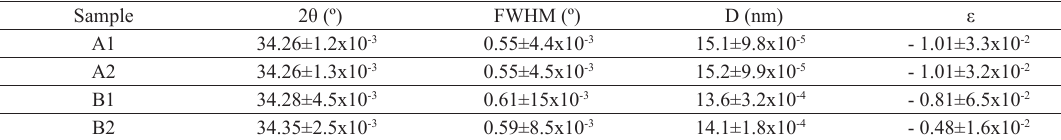
Figure 4. Scanning electron micrograph of the AZO/PET films deposited by RF (sample A2). Three positions are indicated where EDS measurements were made. The 001 and 002 positions, which are above cracks, exhibit high concentrations of C, owing to the PET substrate. In contrast, at position 003 only Zn, O and Al, which originate form AZO, are detected. Table 2. Position angles (2θ) and FWHM (β) of the (002) peaks of the spectra of the AZO films and estimated values of the crystallite size (D) and the residual tension (ε) of the film/substrate. The 2θ angle of the (002) peak and the FWHM of bulk ZnO bulk were 34.48 o and 0.32 o ,